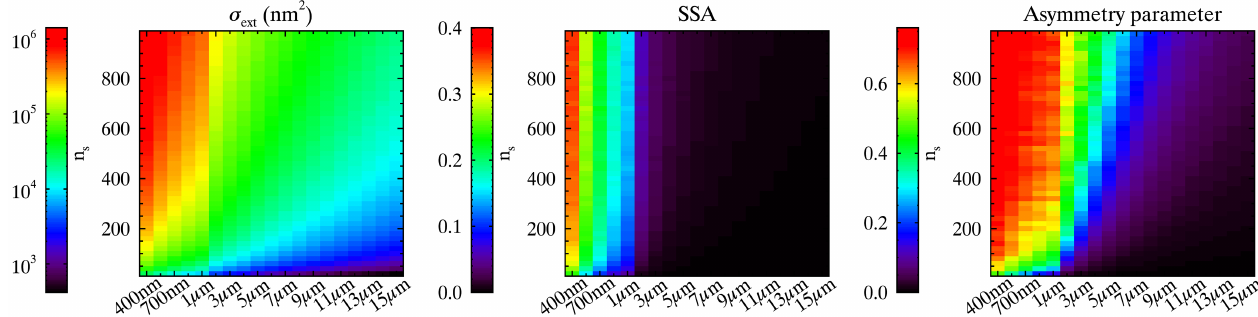
Figure 7. Extinction cross section, single scatter albedo, and asymmetry parameter calculated using the MSTM code at D f = 1 . 8. Note the discontinuity in wavelength step size at λ = 1µm. Unlabelled wavelengths are halfway between the two values on either side.